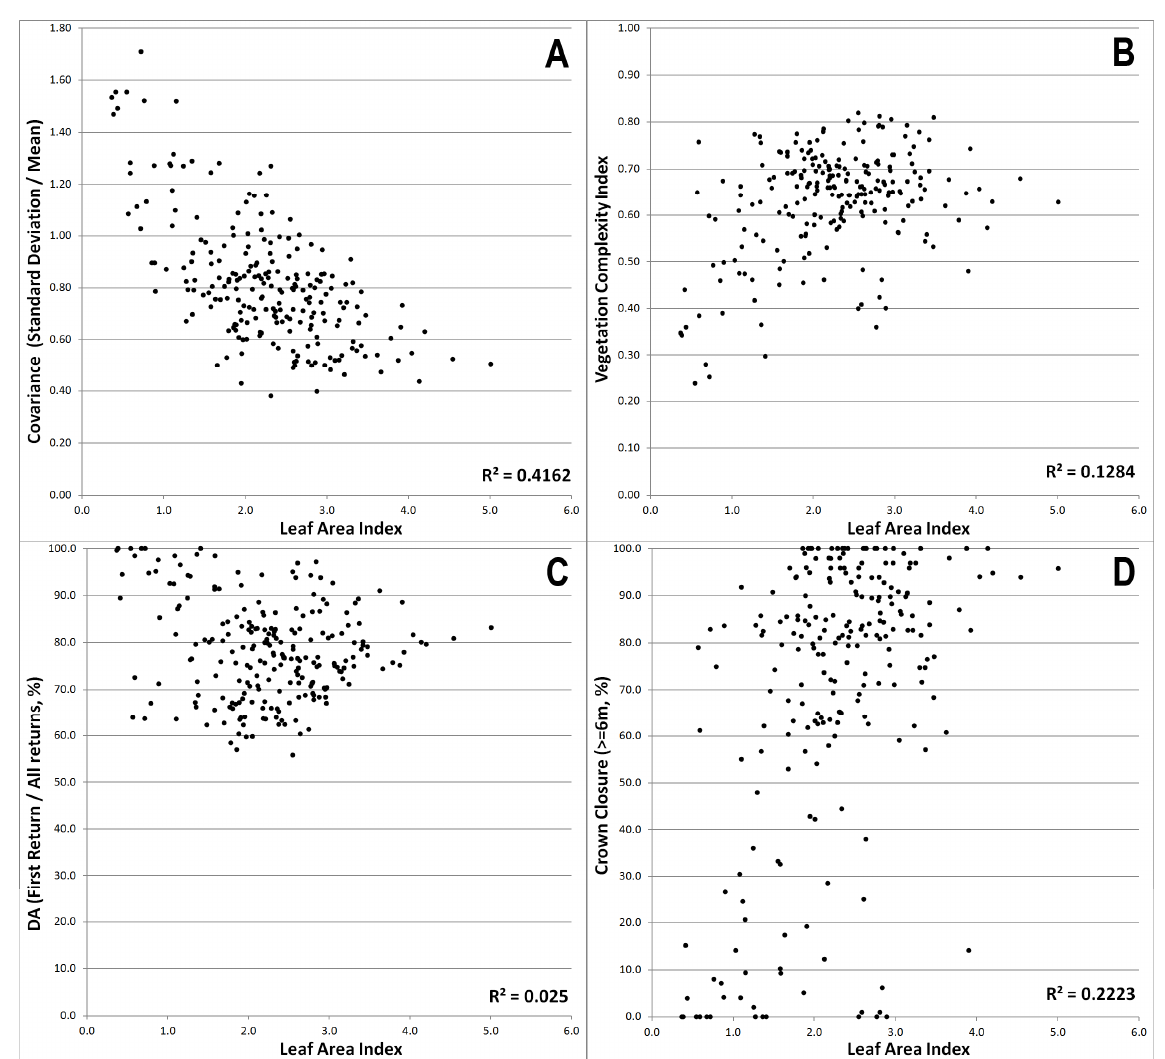
Figure 12. Comparison of LAI and ( A ) COVAR, ( B ) VCI, ( C ) DA, and ( D ) crown closure ( ≥ 6 m) for n = 225